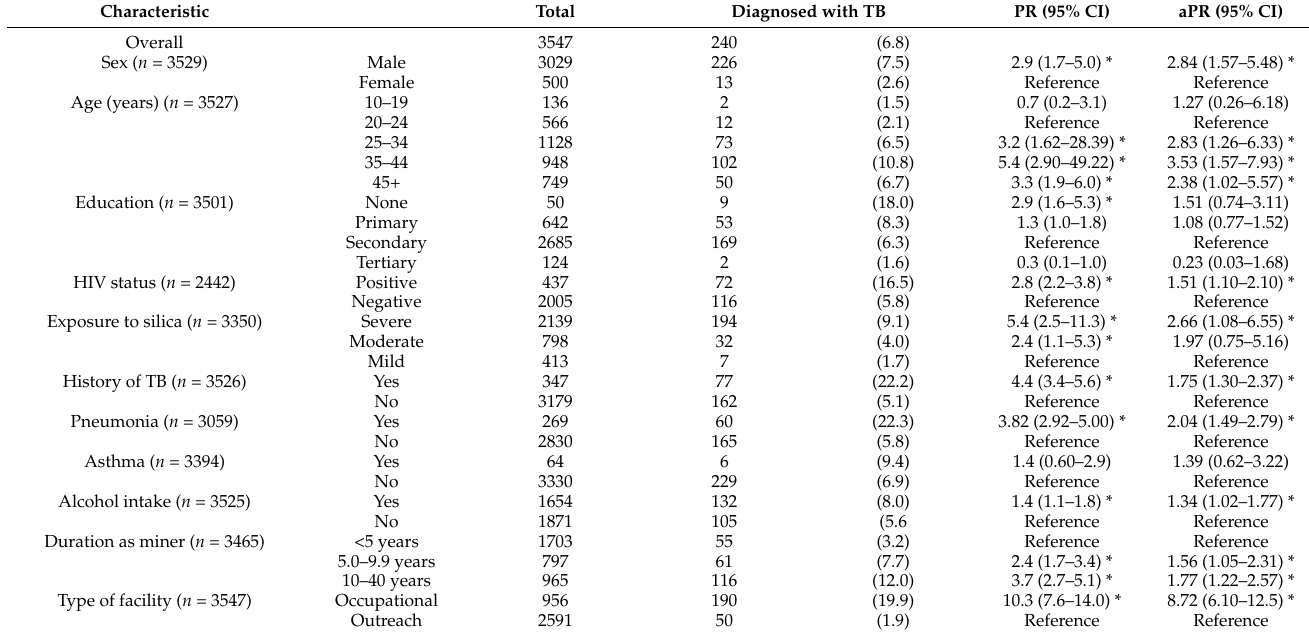
Table 4. Factors associated with TB diagnosis among artisanal and small-scale miners in Zimbabwe.